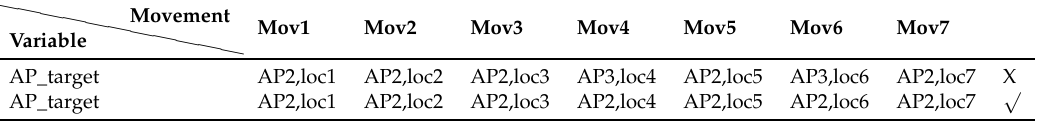
Table 6. AP_target example.